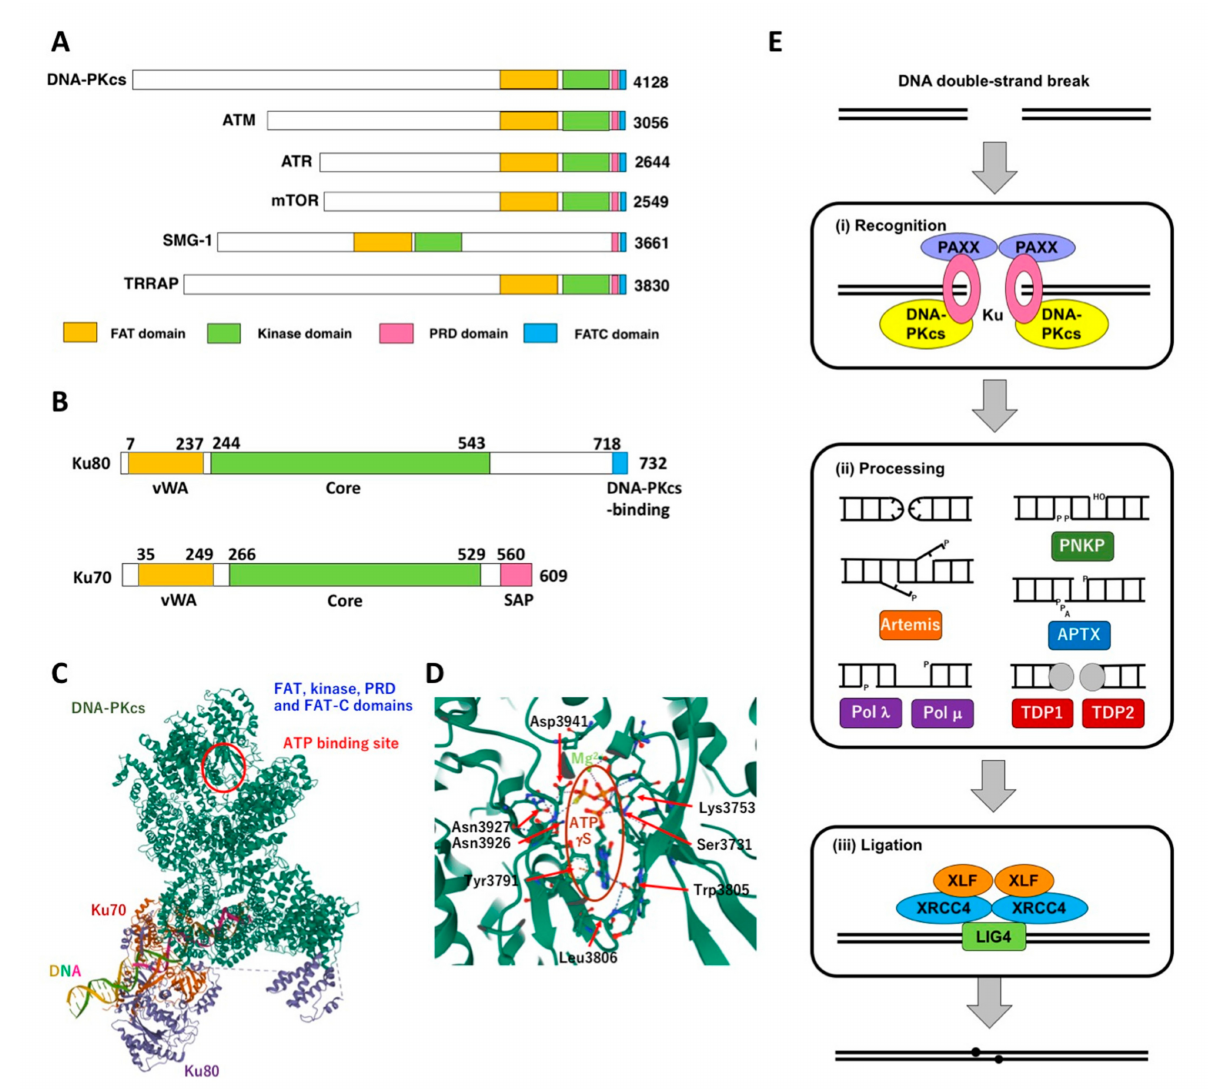
Figure 2. Structure of DNA-PK and its role in NHEJ. ( A ), structure of DNA-PKcs and other PIKK family members. FRAP, ATM and TRRAP (FAT) domain, PIKK-regulatory domain (PRD) and FAT C-terminal (FATC) domains are highlighted. ( B ), structure of Ku80 and Ku70. The von Willebrant factor A (VWA) domain, core domain, SAF-A/B, Acinus and PIAS (SAP) domain and DNA-PKcs binding motif are highlighted. ( C ), the structure of DNA-PKcs complexed with Ku70, Ku80 and dsDNA (RCSB PDB 7K0Y). ( D ), the structure of DNA-PKcs bound to ATP γ S (RCSB PDB 7OTP). ( E ), a model for NHEJ. NHEJ proceeds in three stages, ( i ) the recognition stage, ( ii ) the processing stage and ( iii ) the ligation stage. DNA-PK acts in the recognition stage. Figures ( A , B , E ) are